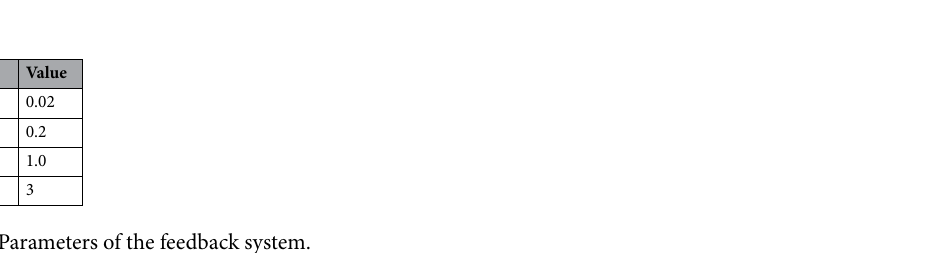
Table 2. Parameters of the feedback